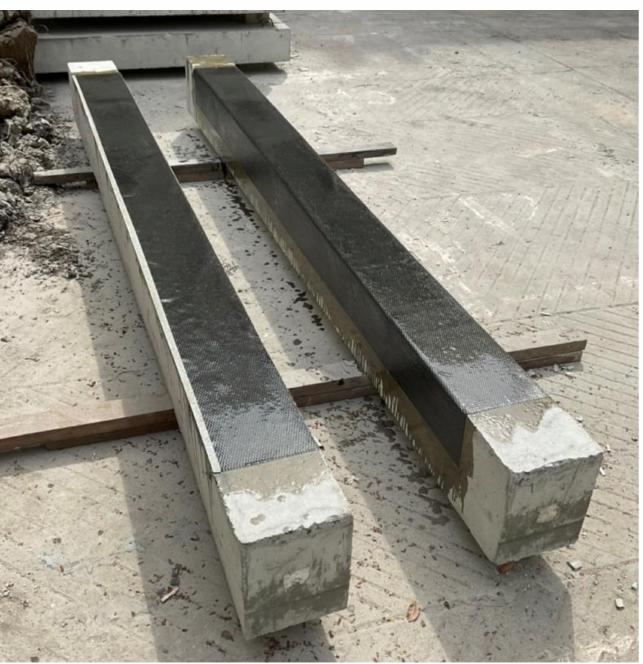
Figure 3. Application of CFRP sheet on bottom of beams ( left ) tension side only ( right ) u-shape